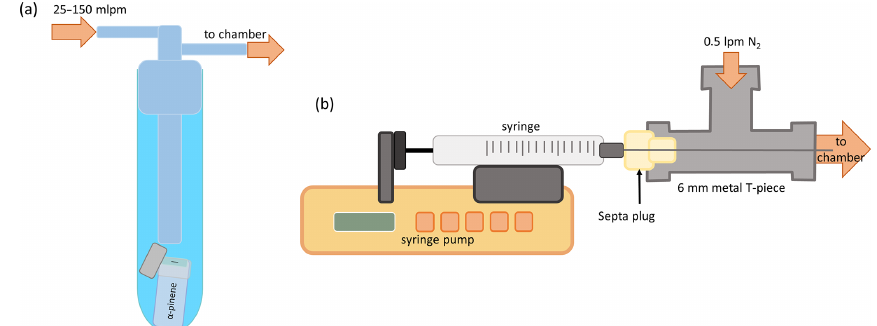
Figure A1. α -pinene injection set-ups used in the experiments. (a) The overflow injection set-up was a gas bubbler into which the small glass vial holding the precursor sample (and its cap) were inserted. (b) The syringe pump injection set-up consists of a syringe pump, a syringe, a metal T piece, and a septa